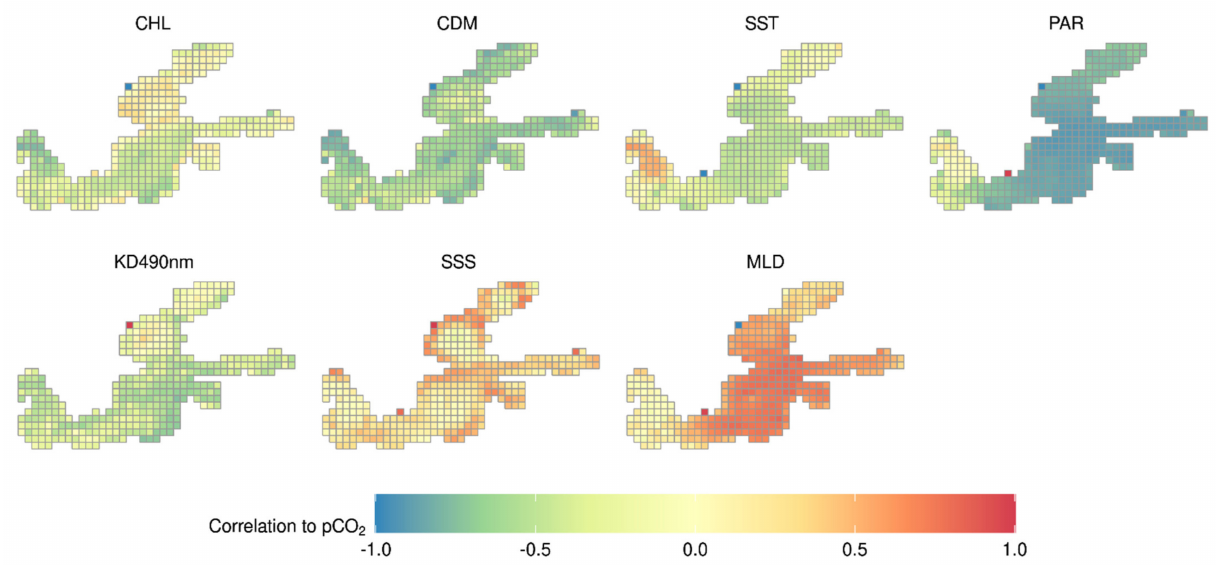
Figure 7. The spatial correlation between the estimate pCO 2 and the variables the study period of 2002–2011. The size of grid cells is 0.5 ◦ × 0.5 ◦ . Minus value the variable was negatively correlated to the pCO 2 there and the positive values mean positive